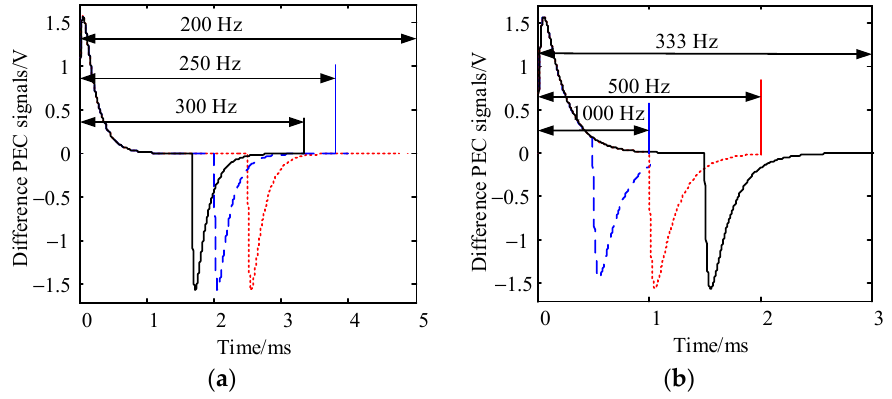
Figure 7. The difference PEC signals with different frequencies. ( a ) lower frequency; ( b ) higher frequency.